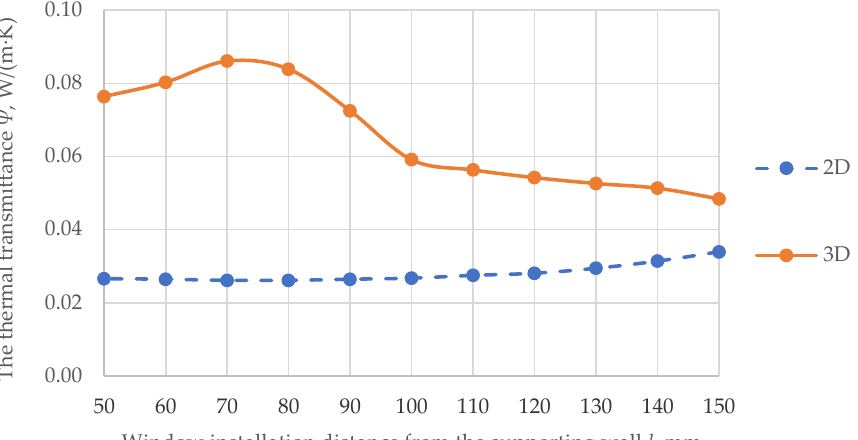
Figure 14. Trends in the values of thermal bridges due to the change of the installation location in the layer of thermal insulation material, applying different calculation methodologies.